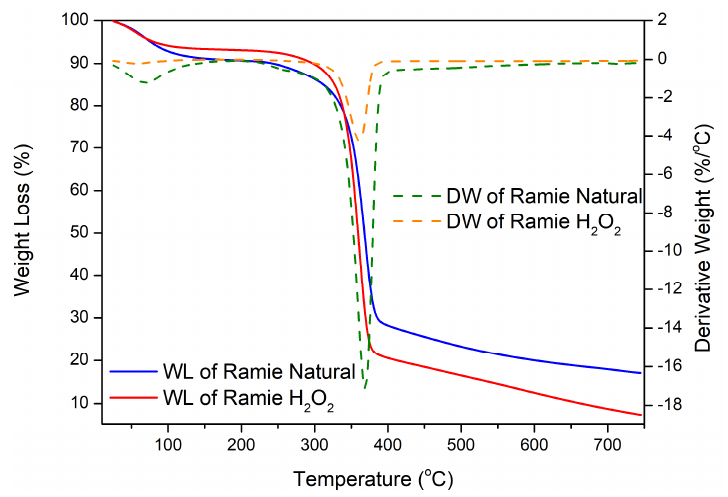
Figure 11. TGA/DTG curves of RN and RH.